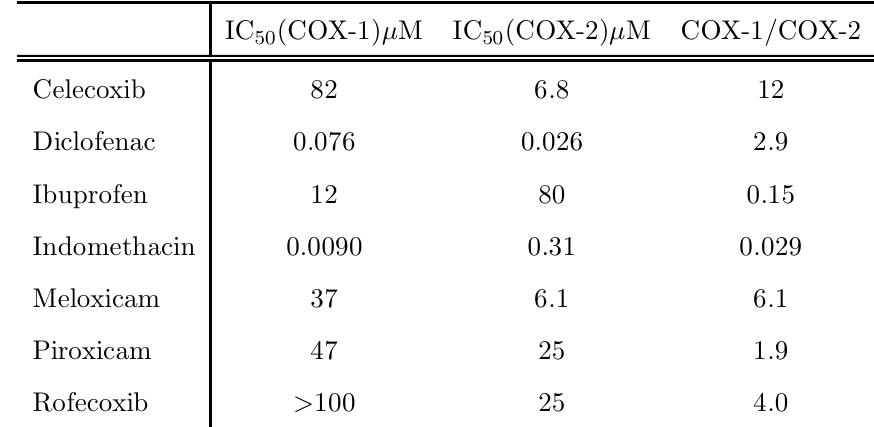
Table 3 Mean IC 50 values for COX-1 and COX-2 ( · M) and the COX-1/COX-2 ratio of some